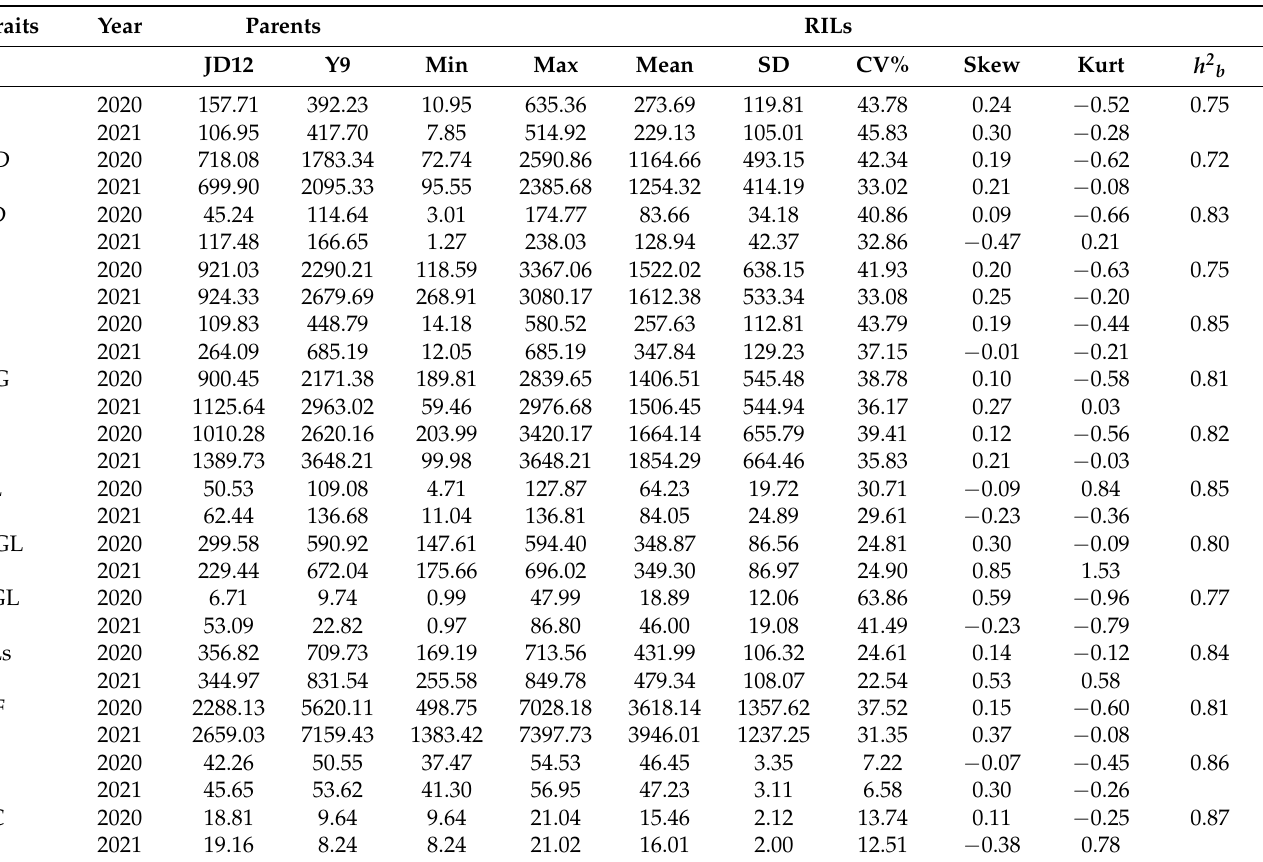
RILs: recombinant inbred lines. The traits observed are concentrations of 12 isoflavones, proteins and oils: D (daidzin, µ g/g), MD (malonyldaidzin, µ g/g), AD (acetyldaidzin, µ g/g), Ds (sum of daidzein derivatives, µ g/g), G (genistin, µ g/g), MG (malonylgenistin, µ g/g), Gs (sum of genistein derivatives, µ g/g), GL (glycitin, µ g/g), MGL (malonylglycitin), AGL (acetylglycitin, µ g/g), GLs (sum of glycitein derivatives, µ g/g), TIF (total isoflavone, µ g/g), PC (protein content, %), OC (oil content,